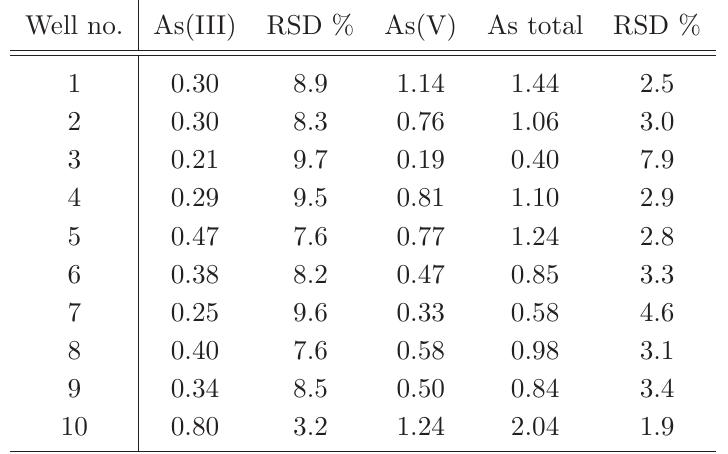
Table 6 Results of arsenic species content determination in samples of ground water